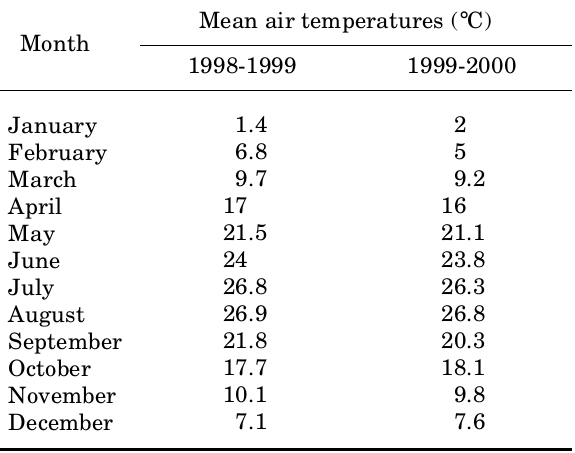
Table 3. Mean air temperatures for the years 1998-1999 and